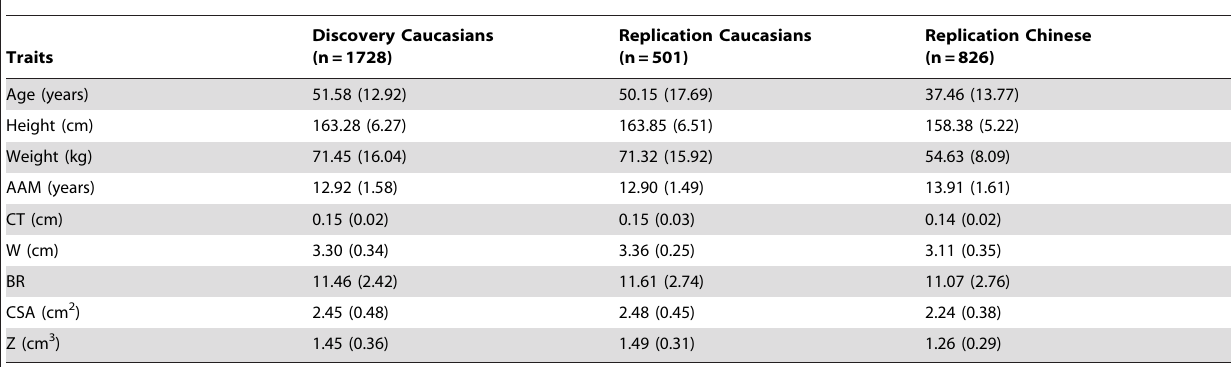
Table 1. Basic characteristics of the study subjects.